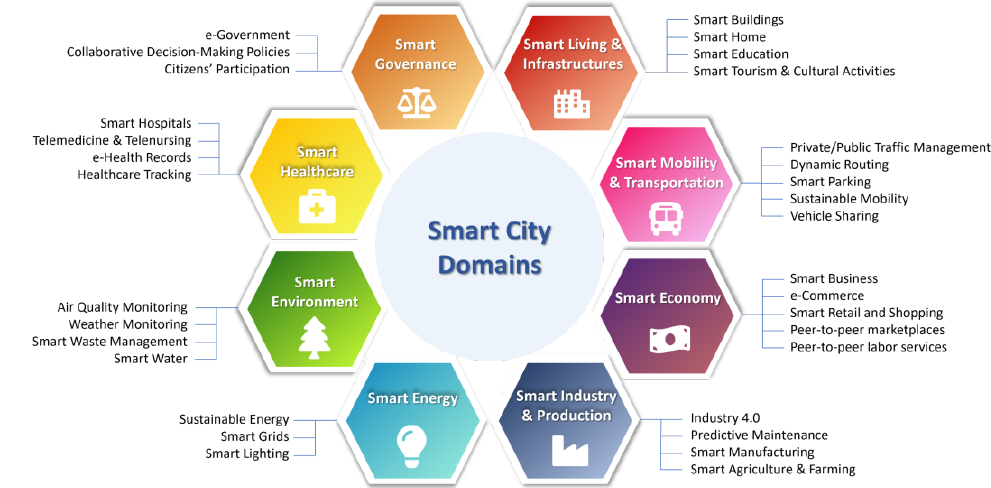
Figure 3. The classification of smart city domains with related components and application areas.